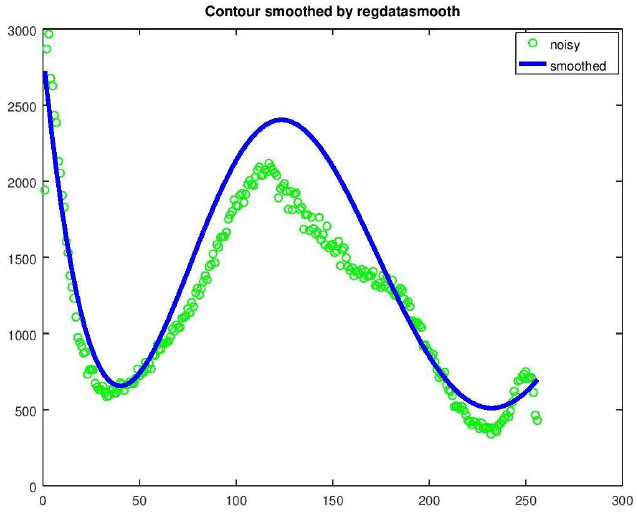
Figure 16. Data-smoothing achieved by regdatasmooth.